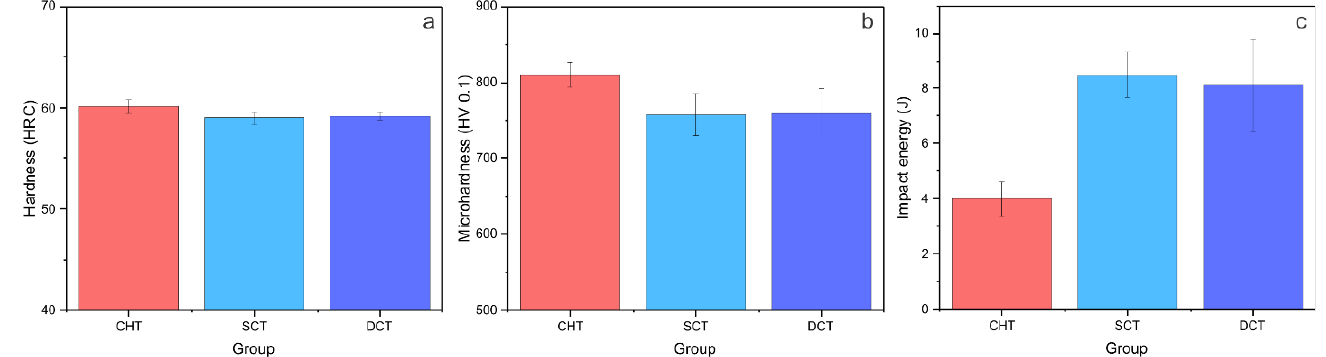
Figure 5. EDS-mapping of all three samples: CHT ( a – e ), SCT ( f – j ) and DCT ( k – o ) for Fe, Cr, C, Nb and V.